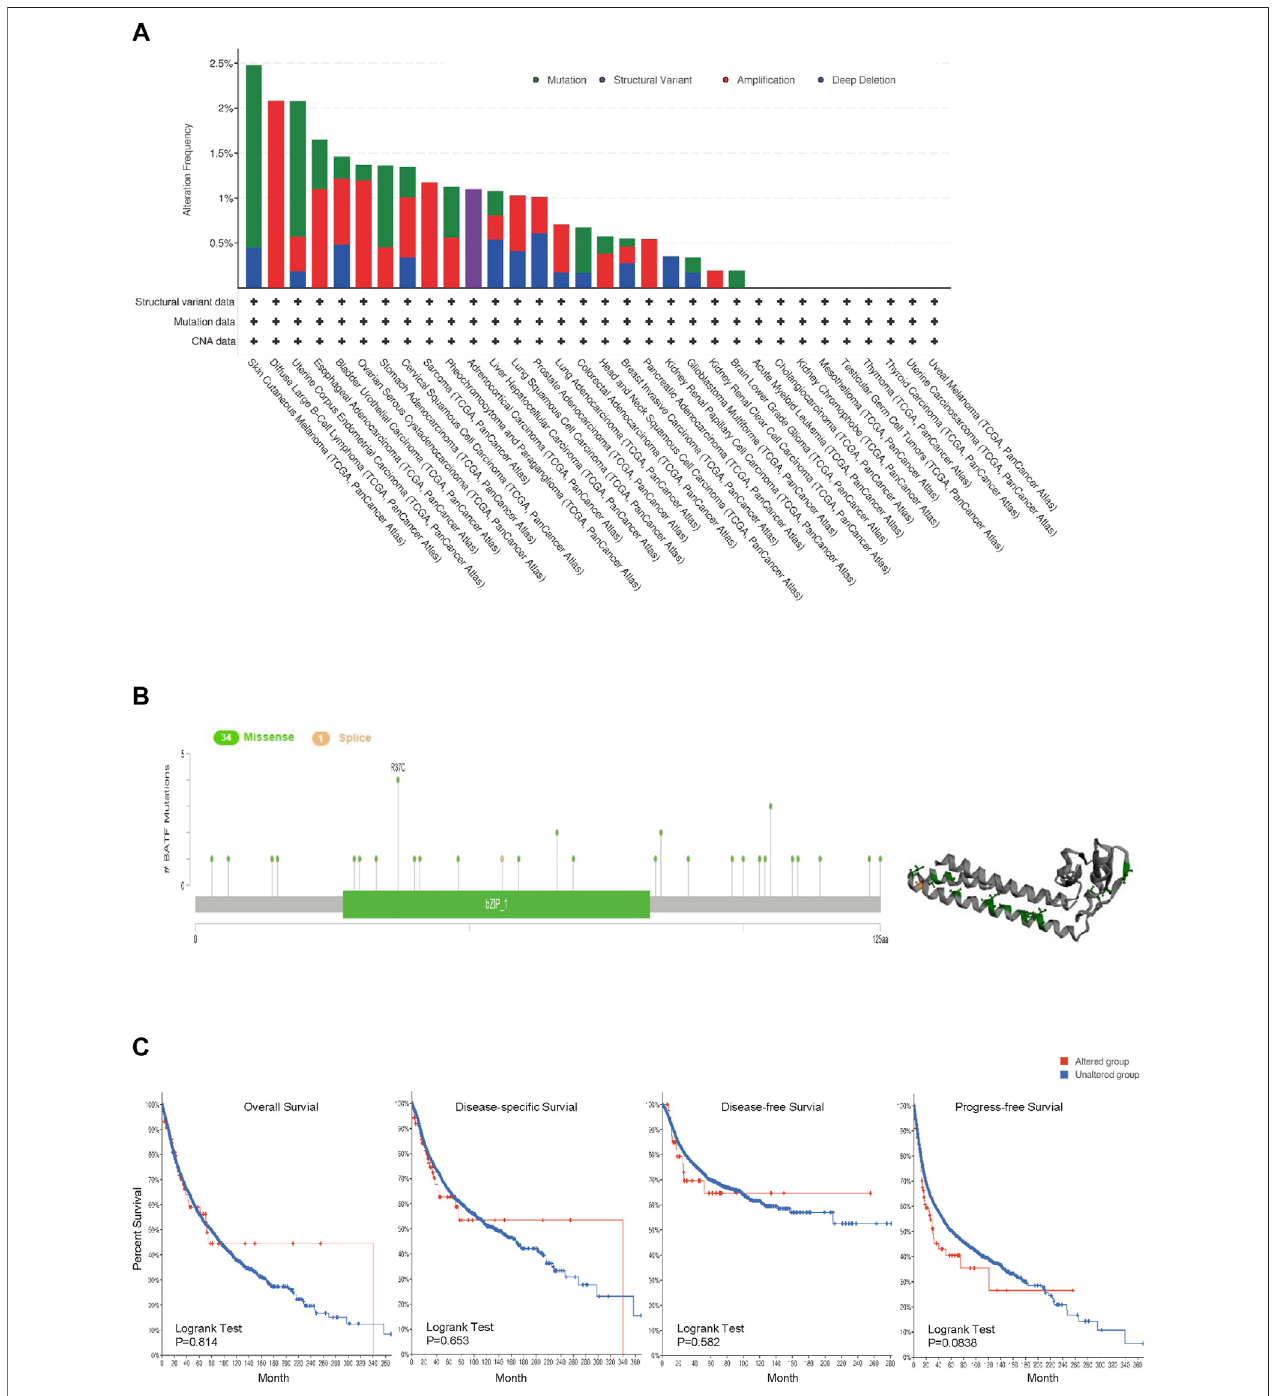
FIGURE 5 | Genetic alterations in BATF in cancers. (A,B) Alteration frequency and mutation types of BATF in tumors. (C) OS, DSS, DFS, and PFS in tumors with BATF genetic alterations.